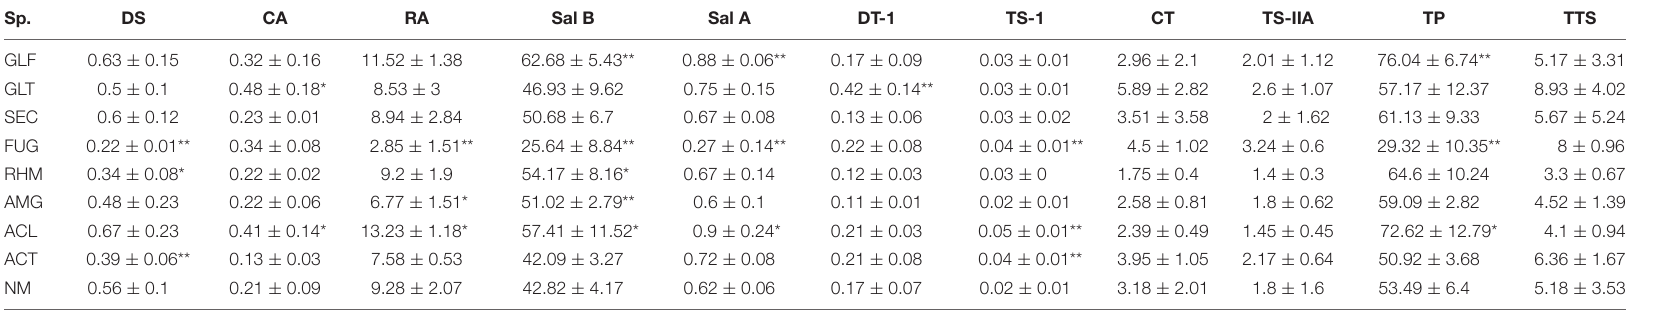
TABLE 4 | Active ingredients molar content (values are expressed on a dry weight basis) in S. miltiorrhiza root (mol · g − 1 DW).